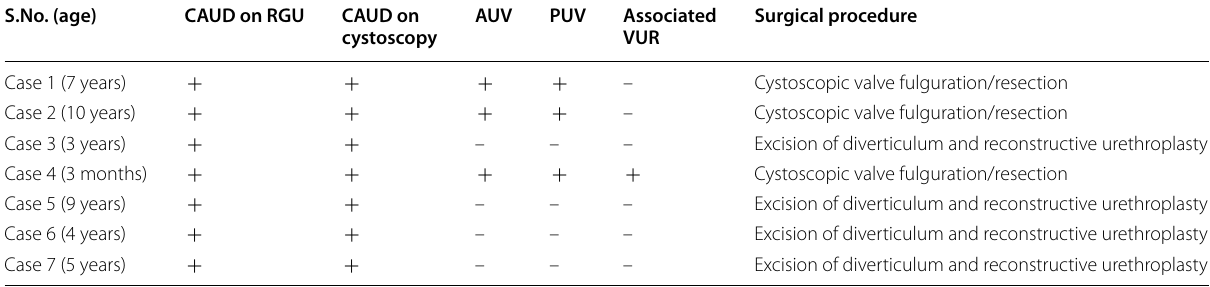
Table 1 Back pressure changes on MCUG with left-sided vesico-ureteric reflux (VUR) associated secondary to PUV S.No. (age) CAUD on RGU CAUD on